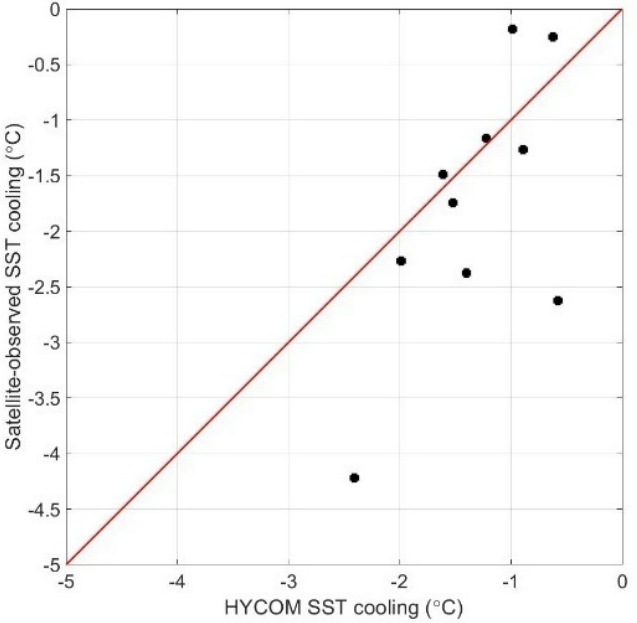
Figure A2. Comparison of the HYCOM and satellite-observed domain-averaged SST cooling. Note that the results corresponding to typhoons Tembin and Bolaven are not shown, because they are too close in time (Table 1) to separate their individual influence on SST cooling.